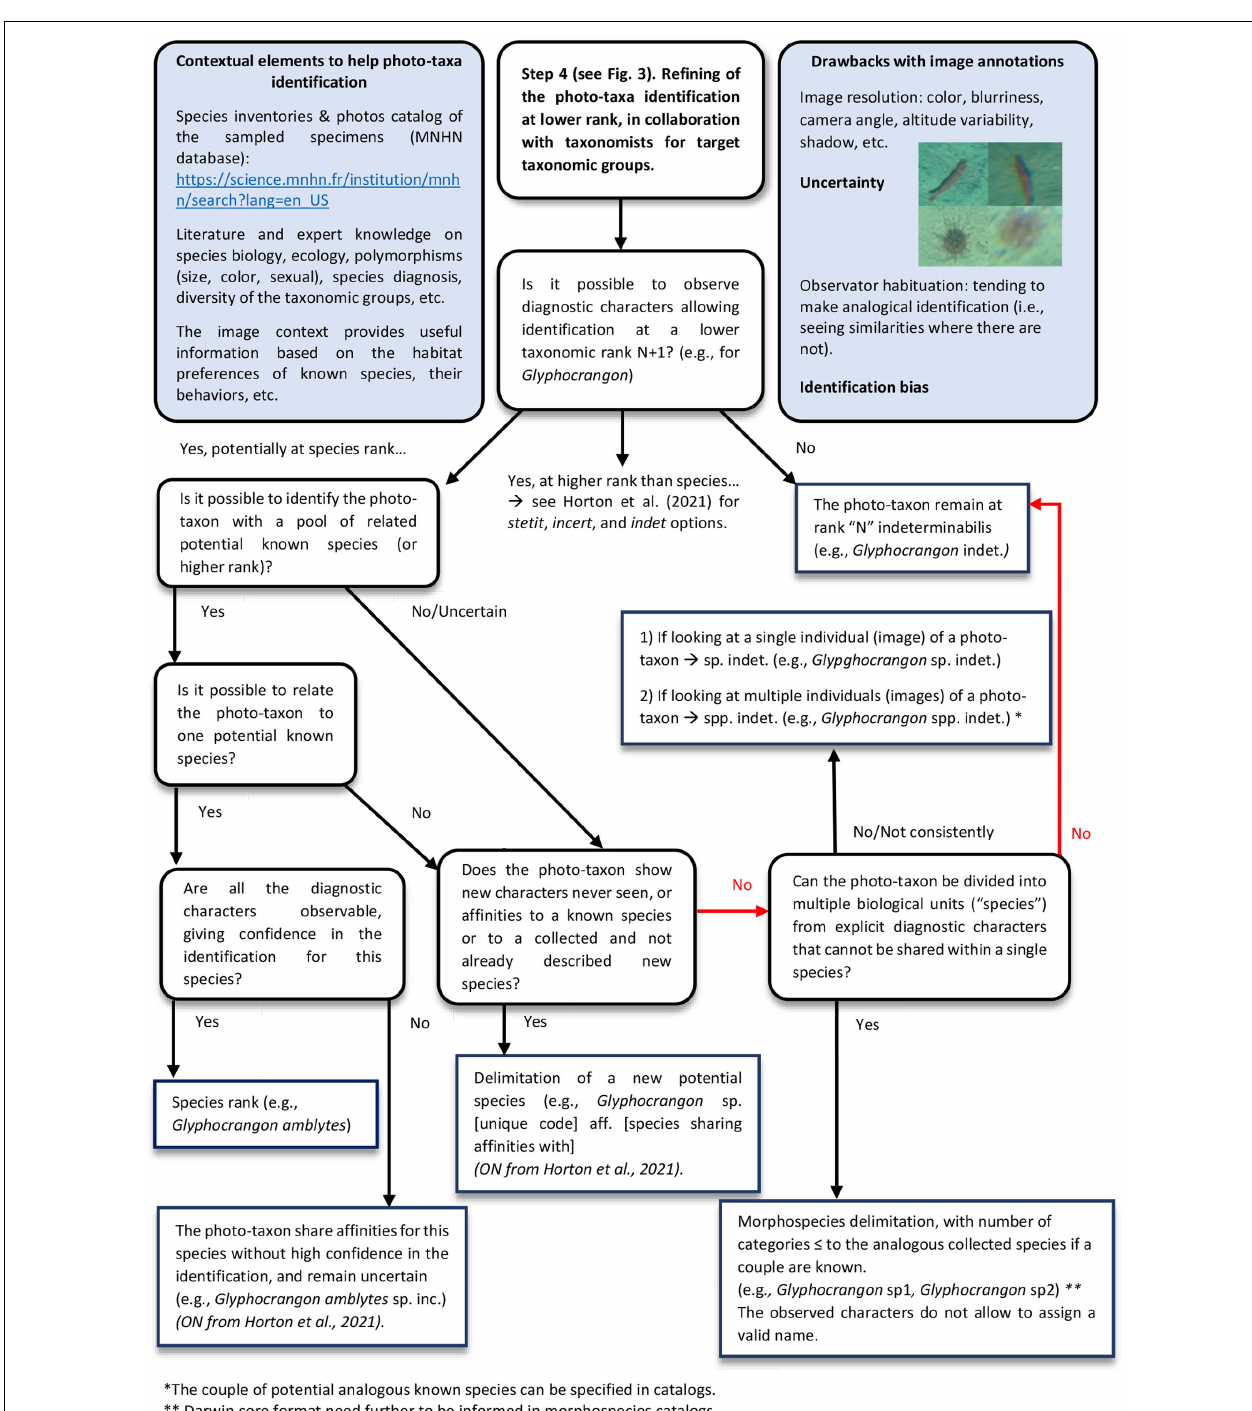
FIGURE 11 | Integrative scheme for photo-taxa identification and nomenclature from